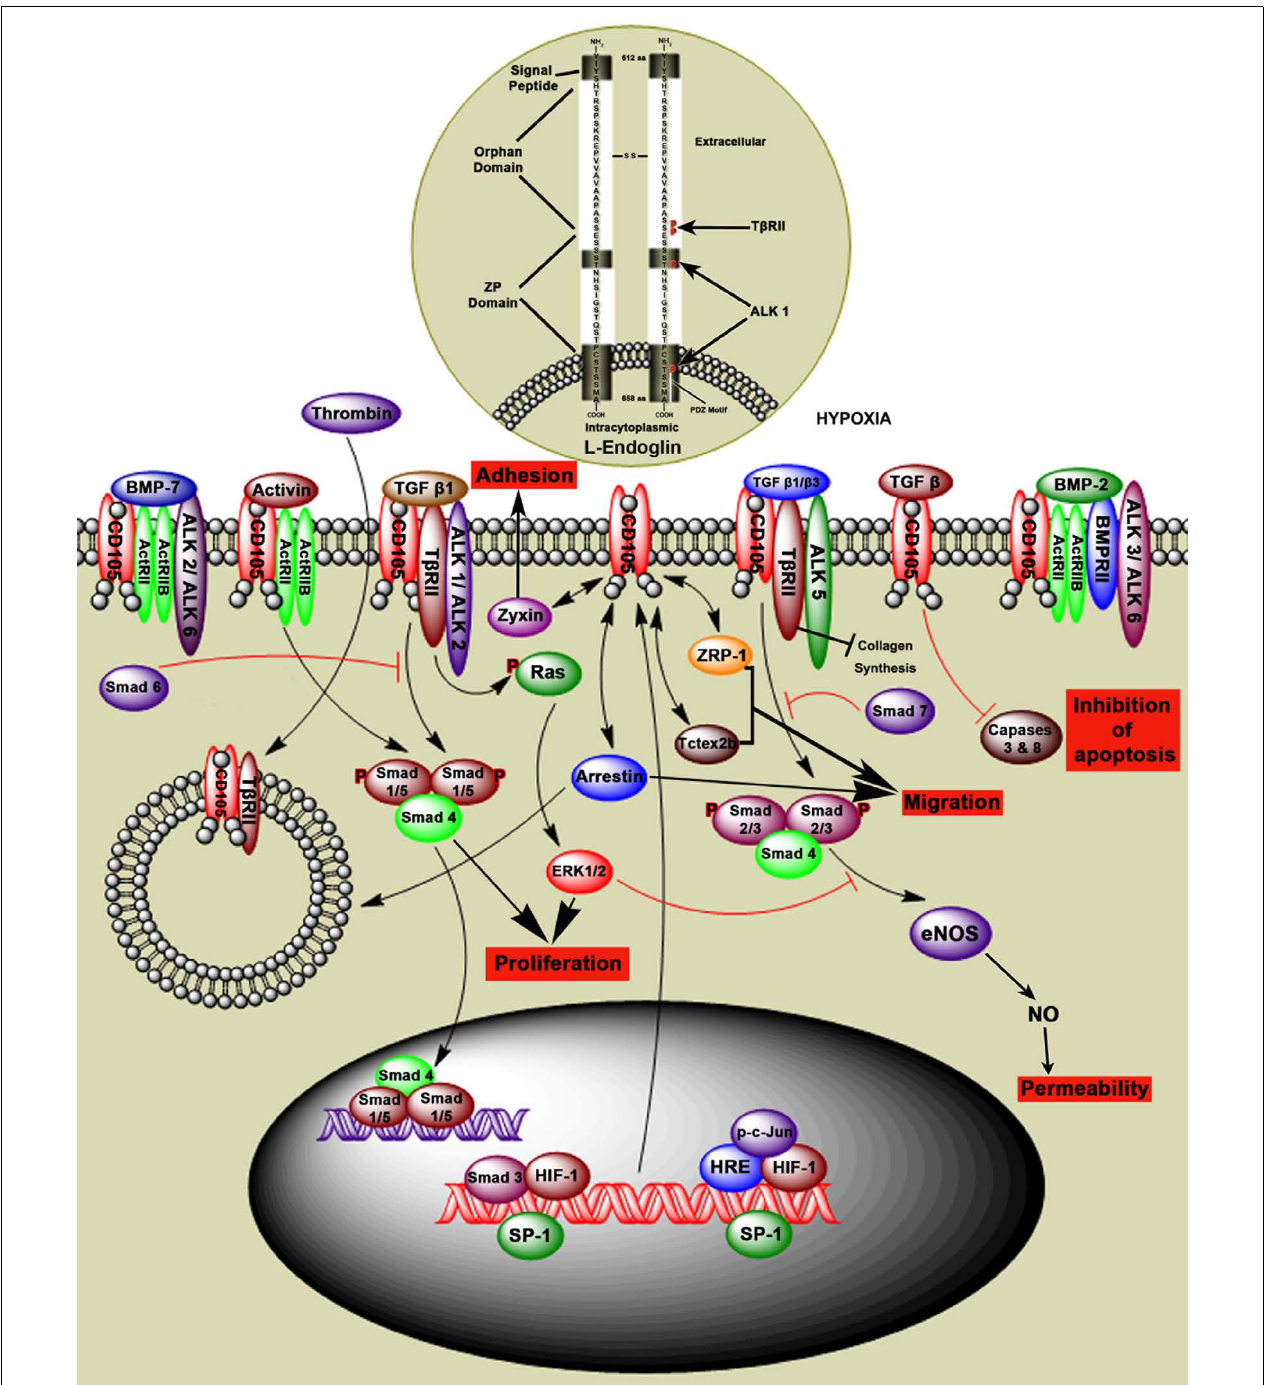
TGF- β 1 and β 3 regulate intracellular Smads (Smad1/5, Smad 2/3, and Smad4) via theTGF- β receptor complex, which regulates cell proliferation, adhesion, and permeability. Intracytoplasmic events show that Smad6 inhibits phosphorylation of Smad1/5 and Smad7 inhibits phosphorylation of Smad2/3. TGF- β signaling through Endoglin induces inhibition of caspases 3 and 8 and therefore inhibition of apoptosis. Endoglin interaction with ZRP-1, Zyxin, and Tctex2b regulates cell adhesion and migration.Thrombin induces internalization of EndoglinTGF- β RII complex by endocytosis.